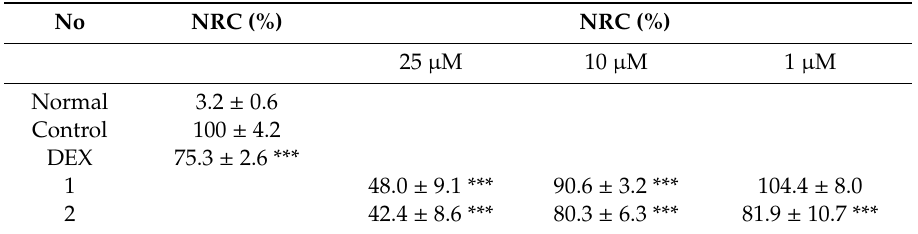
Table 2. Inhibitory effects of 1 and 2 on nitric oxide (NO) production in RAW 264.7 cells. No NRC (%) NRC (%) No NRC (%) NRC (%) 25 µ M 1 µ M Normal